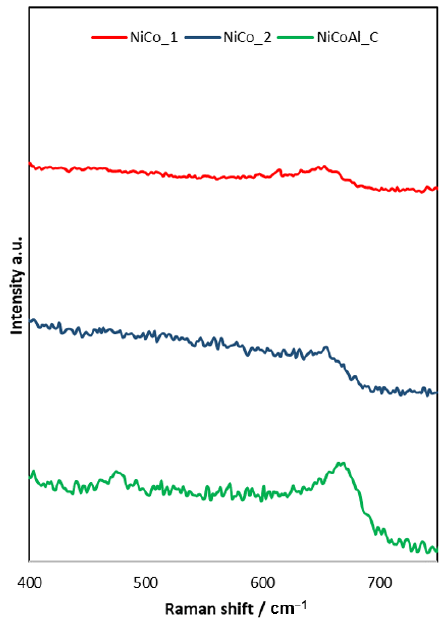
Figure 7. Raman spectrum of NiCo_1, NiCo_2, NiCoAl_C samples.